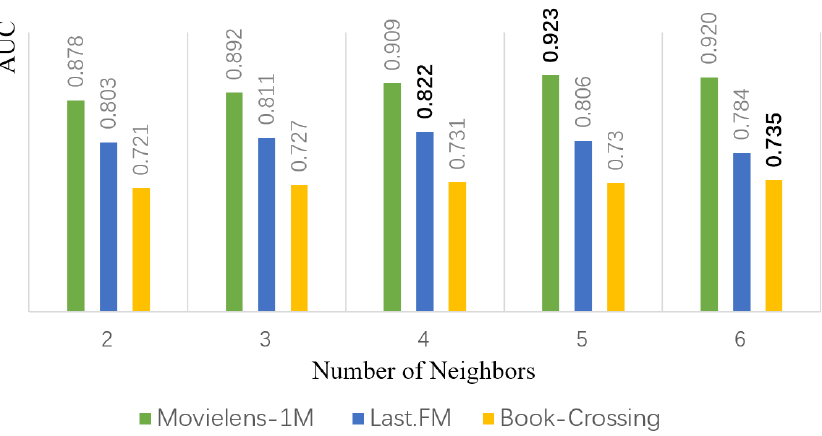
Figure 4. Performance in Different Number of Neighbors.